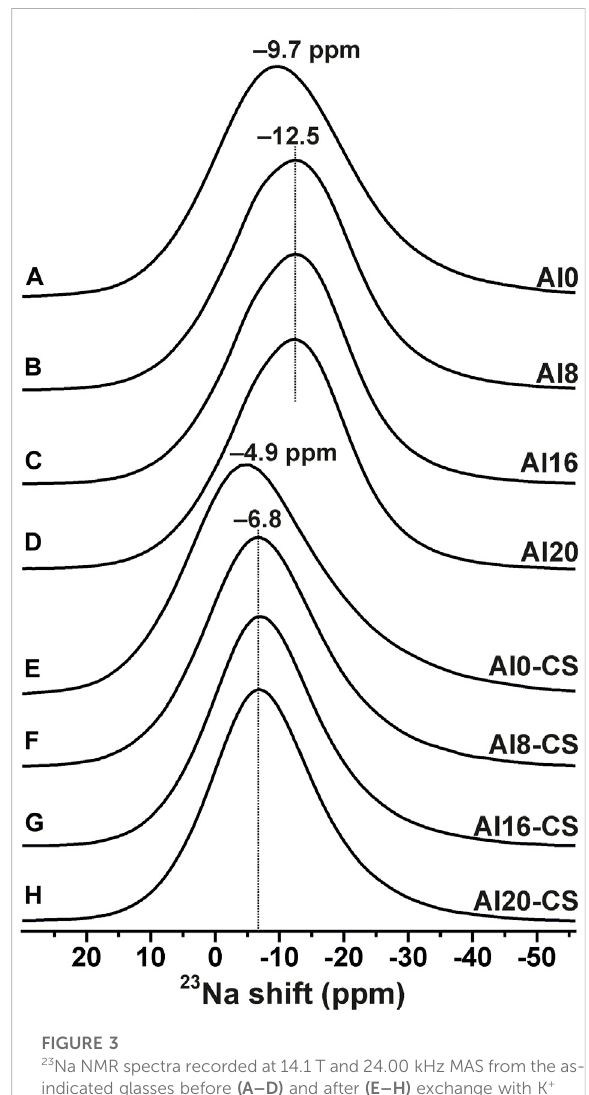
FIGURE 3 23 Na NMR spectra recorded at 14.1 T and 24.00 kHz MAS from the as- indicated glasses before (A – D) and after (E – H) exchange with K + ions. Note that all NMR spectra are normalized to the same maximumpeakheight,andthattheintegratedsignalintensity ofeachspectrumin (E – H) isonly25% – 35% ofthat observed inthe respective pristine glass shown in (A – D) .